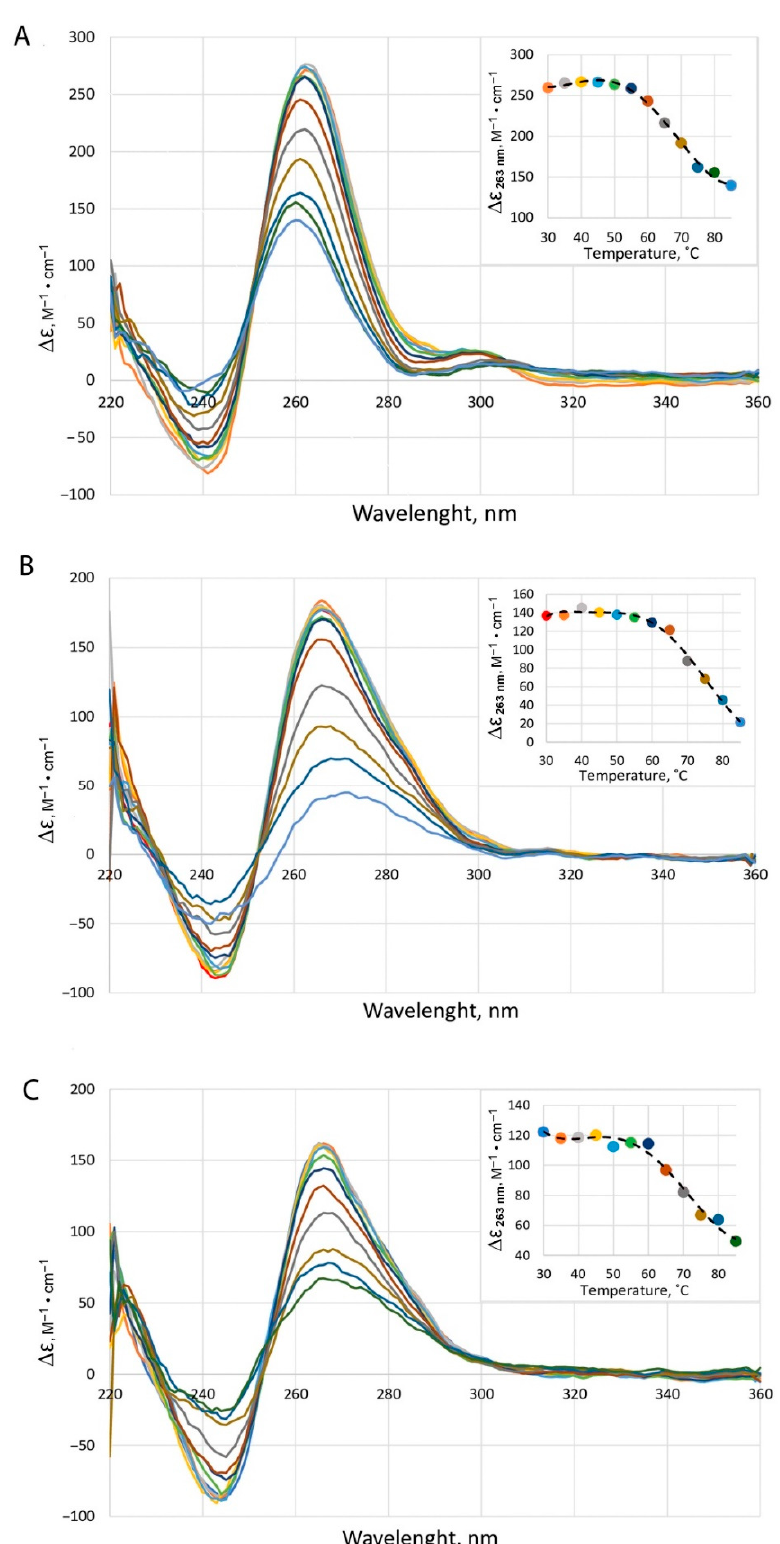
Figure 3. CD spectra and melting profiles of c-MYC G4 alone (~4 µ M oligonucleotide strand concentration) ( A ) and in the presence of an equimolar DNA duplex and either sanguinarine ( B ) or quercetin ( C ) taken in a 1:2 ratio (G4:ligand). CD spectra were recorded in buffer B at different temperatures; the temperature was raised from 30 to 85 ◦ C in 5 ◦ C increments. (Insets) CD-monitored melting profiles at 263